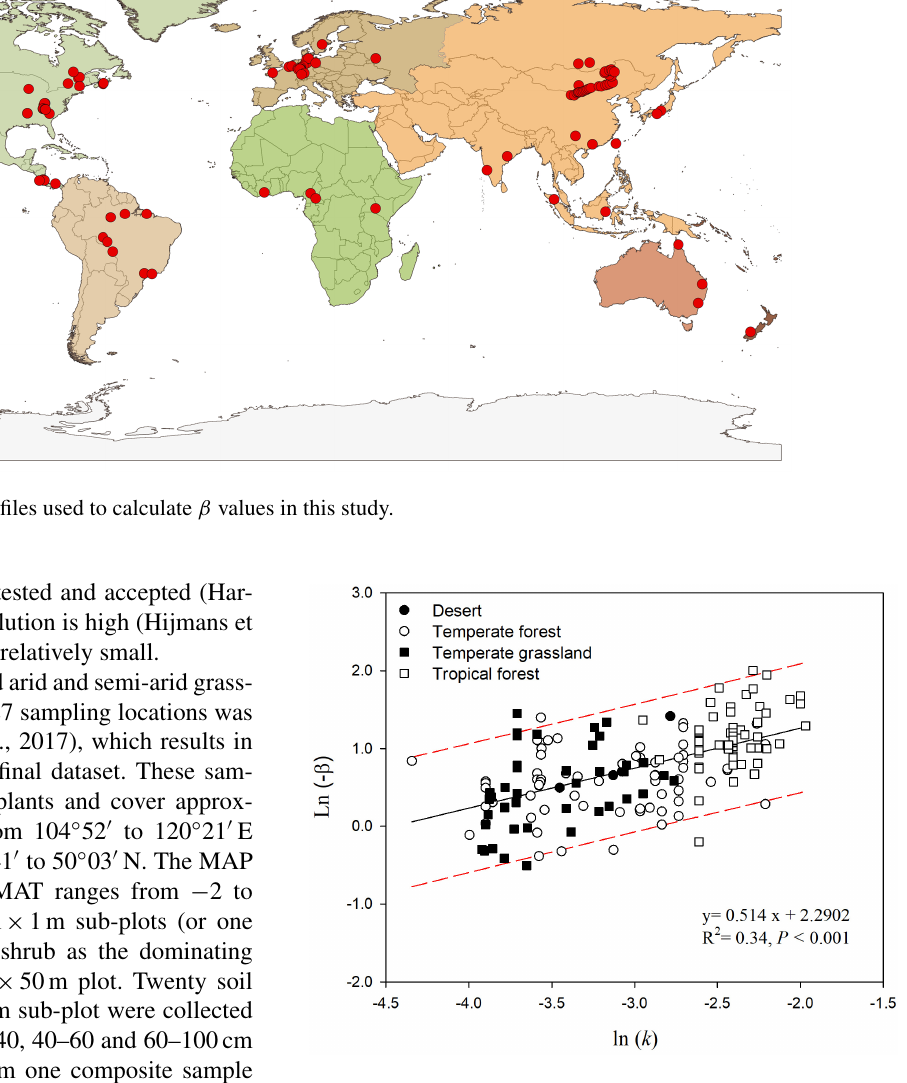
Figure 2. Link between β value and modeled soil carbon turnover rate ( k) , which was estimated as the ratio between soil heterotrophic respiration and soil carbon stocks. Solid line is regression line and dashed lines denote 95% prediction